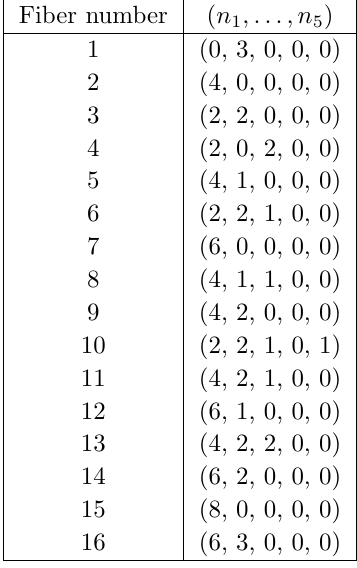
Table 1 . Distinguishing values of n i = jr 2 \ S i j for the 16